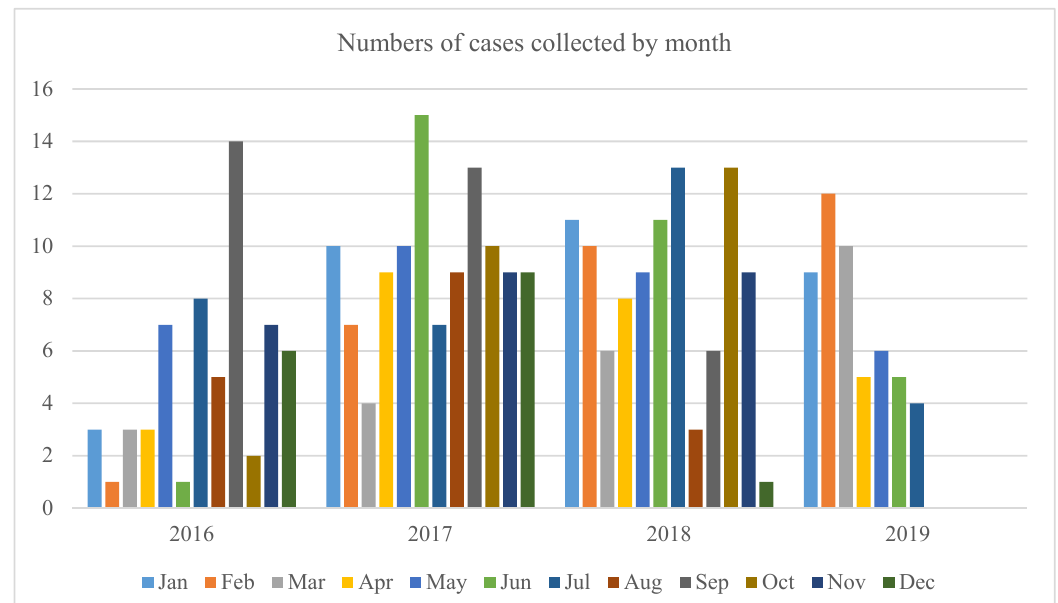
Figure 3. Numbers of cases collected per month.